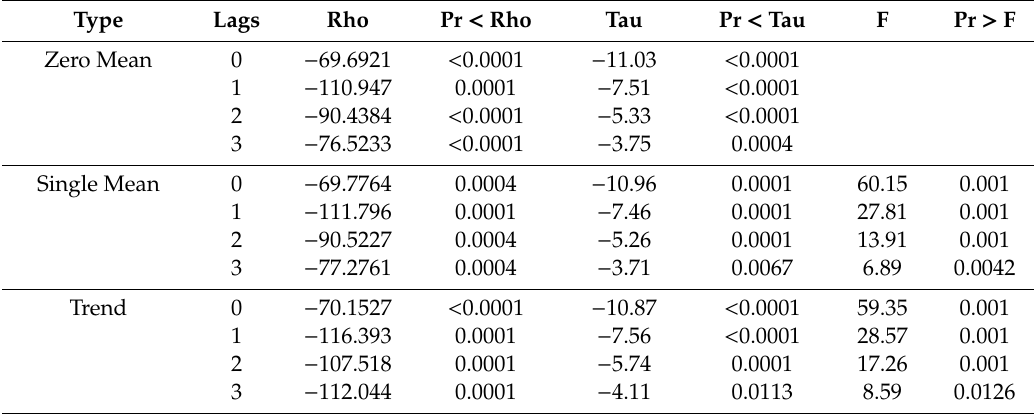
Table 1. Augmented Dickey-Fuller Unit Root Tests.